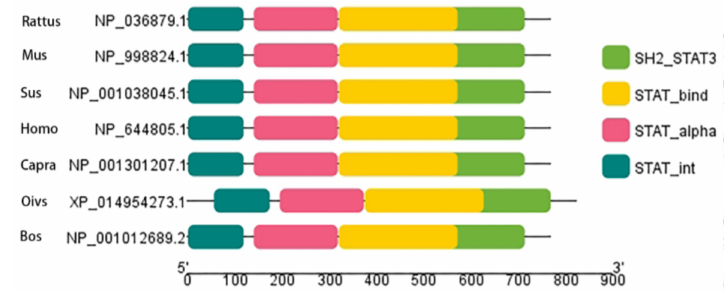
Figure 4. Structure of STAT3 protein domain families in seven species. Each color block is a specific hit representing a different domain